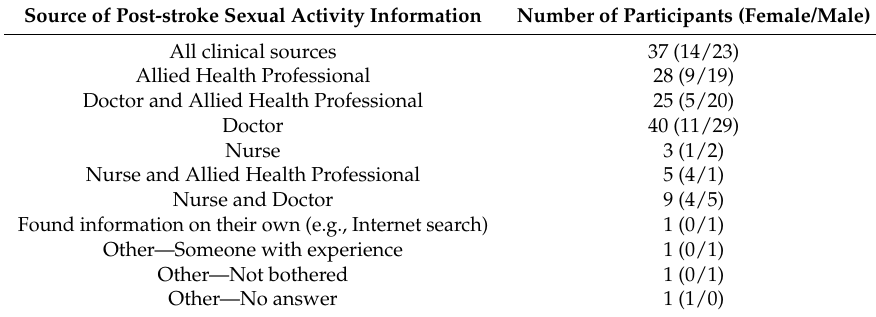
Table 2. Preferred sources of post-stroke sexual activity information.